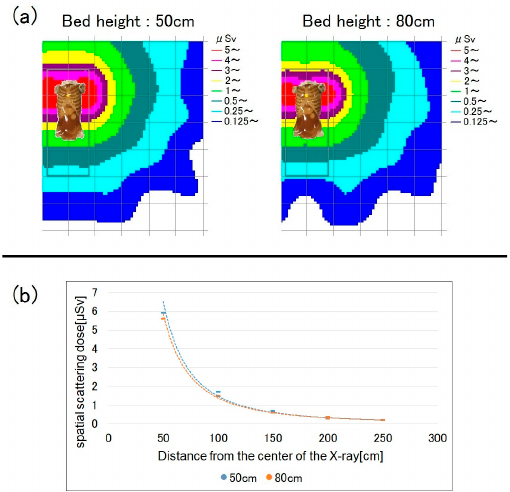
Figure 4. Spatial scattered radiation dose by bed height at a measurement height of 100 cm. ( a ) Dose-distribution map and ( b ) graph showing the spatial doses. Table 1. Summary of the phantom study. Distance from the Center of the X-ray 50 cm 100 cm 150 cm 200 cm 250 cm Scattered radiation dose by bed height (measurement